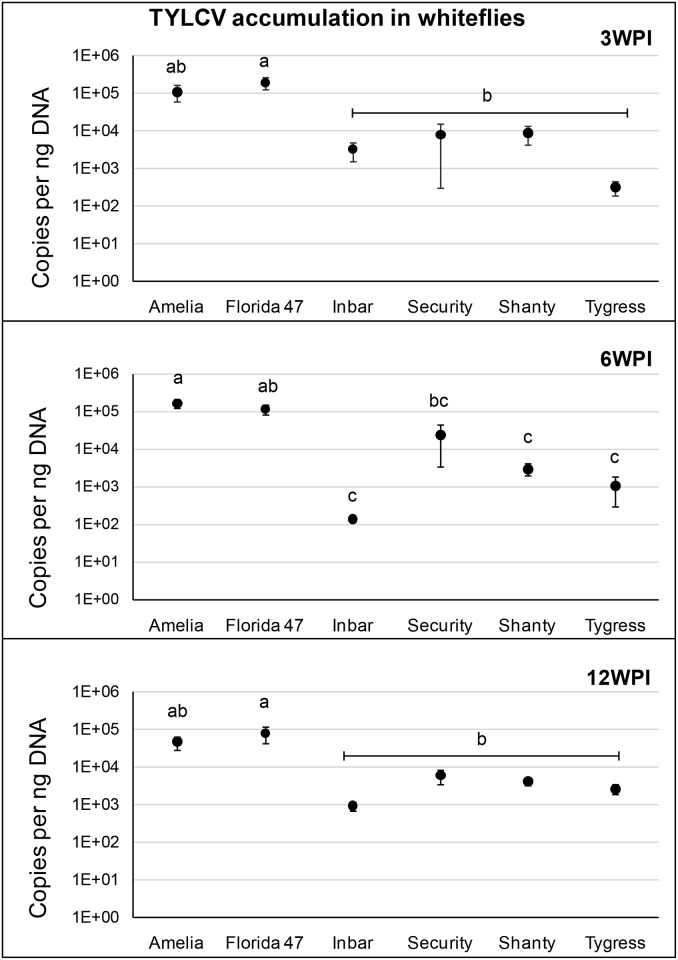
TYLCV acquisition by whiteflies (B. tabaci) at 3, 6 and 12 weeks post inoculation (WPI).Circles with standard errors represent average number of TYLCV C2 copies accumulated in whitefly samples (5 whiteflies in each sample) that were exposed to a 72 h AAP on TYLCV infected foliage of TYLCV-resistant and -susceptible tomato genotypes followed by 72 h of caging on cotton plants. Copy numbers were estimated by qPCR followed by absolute quantification using plasmids containing TYLCV C2 gene inserts as standards. Different letters on bars indicate significant differences in copy numbers among treatments as deduced by Tukey-Kramer grouping (α = 0.05). Y-axis is shown in a logarithmic scale.